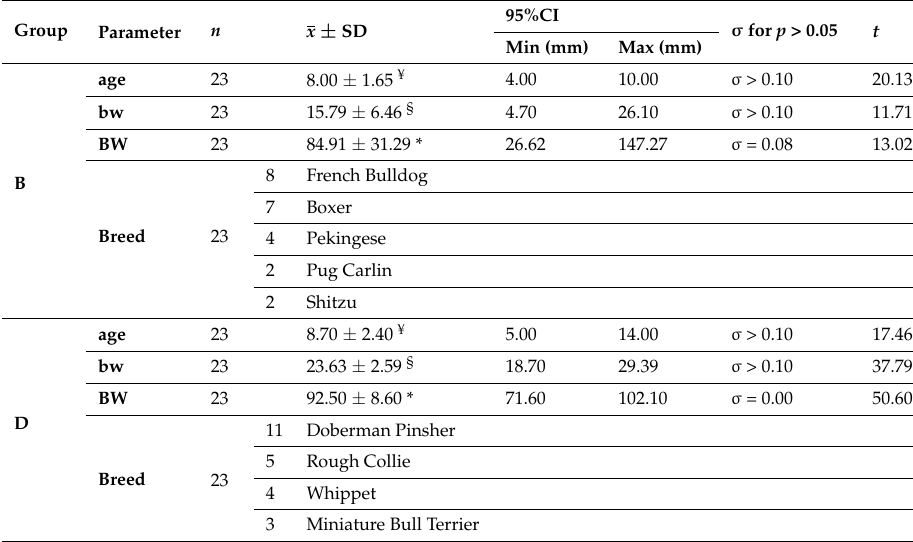
Table 1. Descriptive statistics with mean, standard deviation, minimum and maximum values, sigma and t , regarding the parameters of age, living weight, brain weight, and breeds in brachy (B), dolicho (D) and mesaticephalic (M)